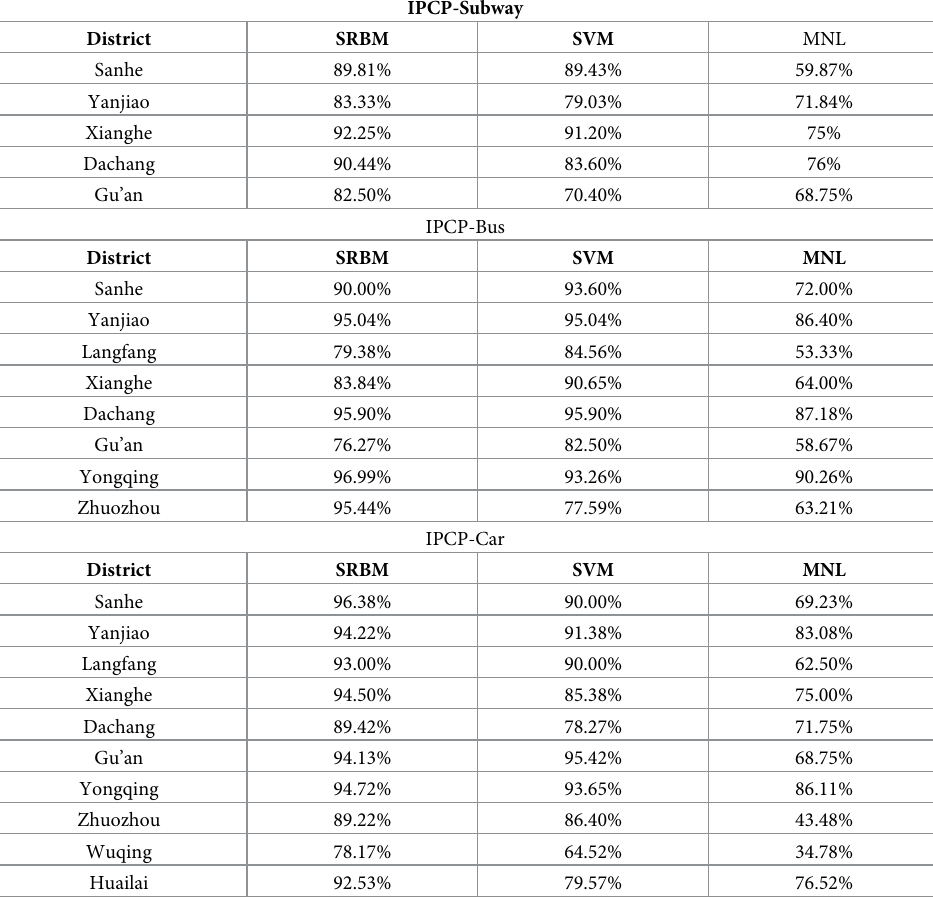
Table 7. Subway, bus, and car accuracy of SRBM, SVM and MNL